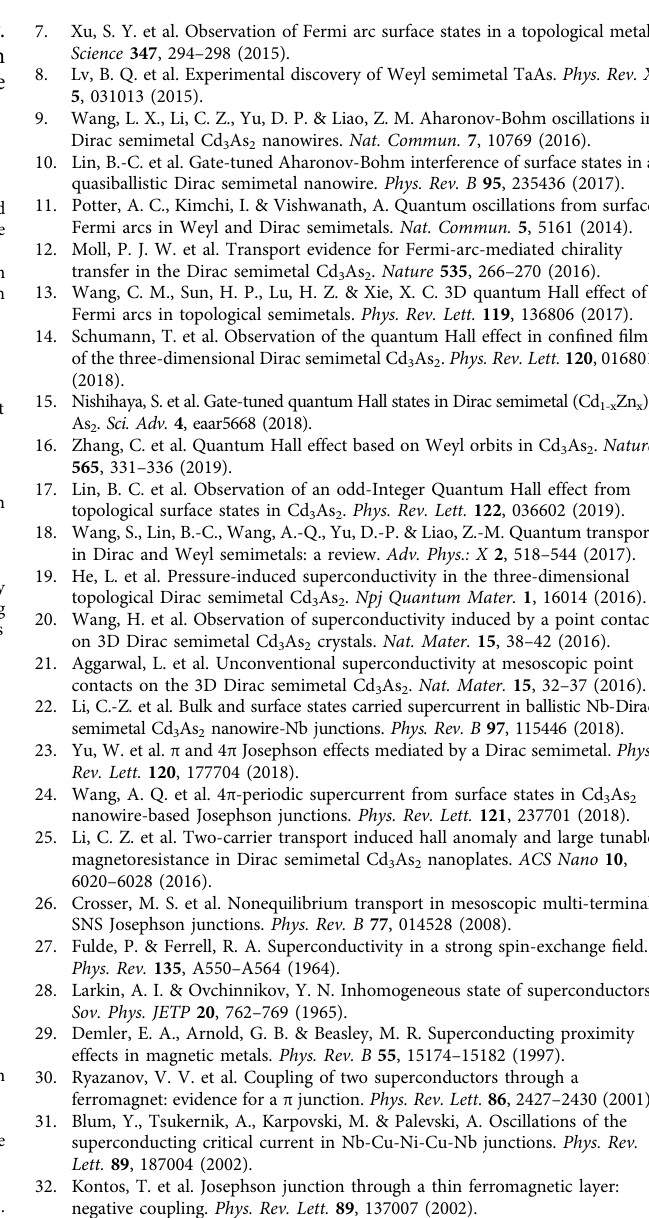
Fig. 5 Modeling Josephson interference in regime of in-plane fi eld orbital effect. a Within two superconducting (SC) leads, pairing electrons traverse from position x 1 of SC1 to position x 2 of SC2, accumulating phase ϕ 2 ( x 2 ) − ϕ 1 ( x 1 ). b The fi t of I c for B > 70 mT using the model of surface in-plane fi eld orbital effect. The experimental data are from the I c ( B ) at V g = − 10